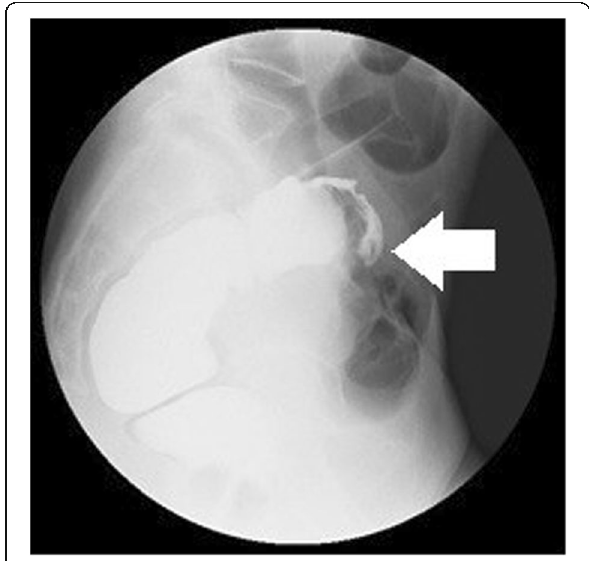
the sigmoid colon